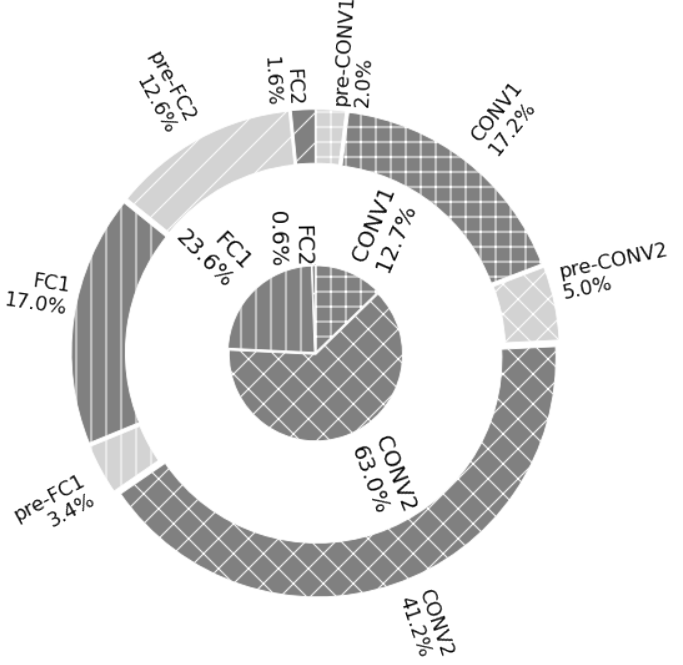
Figure 6. Nested pie charts comparing the (inner) theoretical calculation complexity and (outer) the resulting percentage of the total latency of the layer implemented on the MPA. The pie-chart elapses from zero degrees in a clockwise fashion and different colours correspond to each